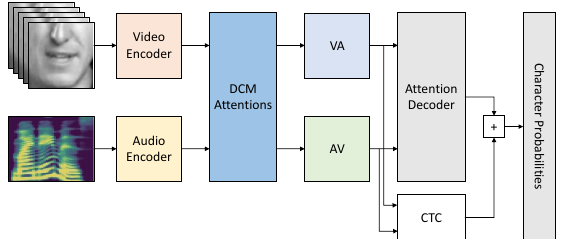
Figure 1. An overview of our proposed audio–visual speech recognition (AVSR) architecture. It consists of four modules: encoders, dual cross-modality (DCM) attentions, an attention decoder, and a connectionist-temporal-classification (CTC) block. The encoders receive each modality and compress their information. DCM attentions are calculated by using different modalities for the queries and the keys. Finally, character probabilities are calculated by using both the attention decoder and the CTC